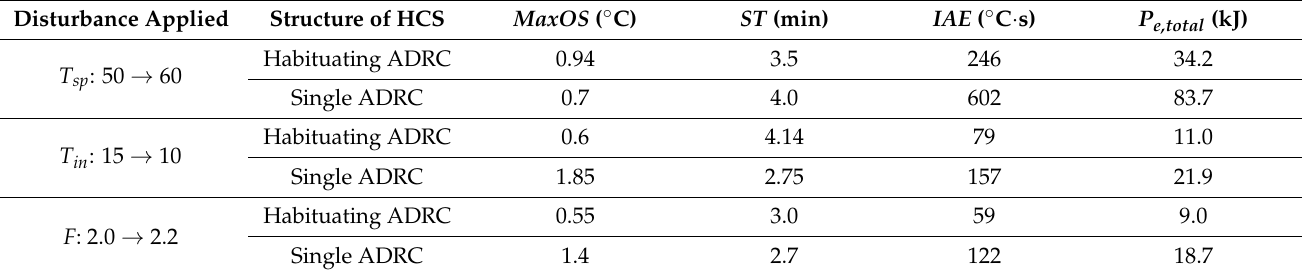
Table 1. Control performance indices for the quantitative comparison of the results presented in Figure